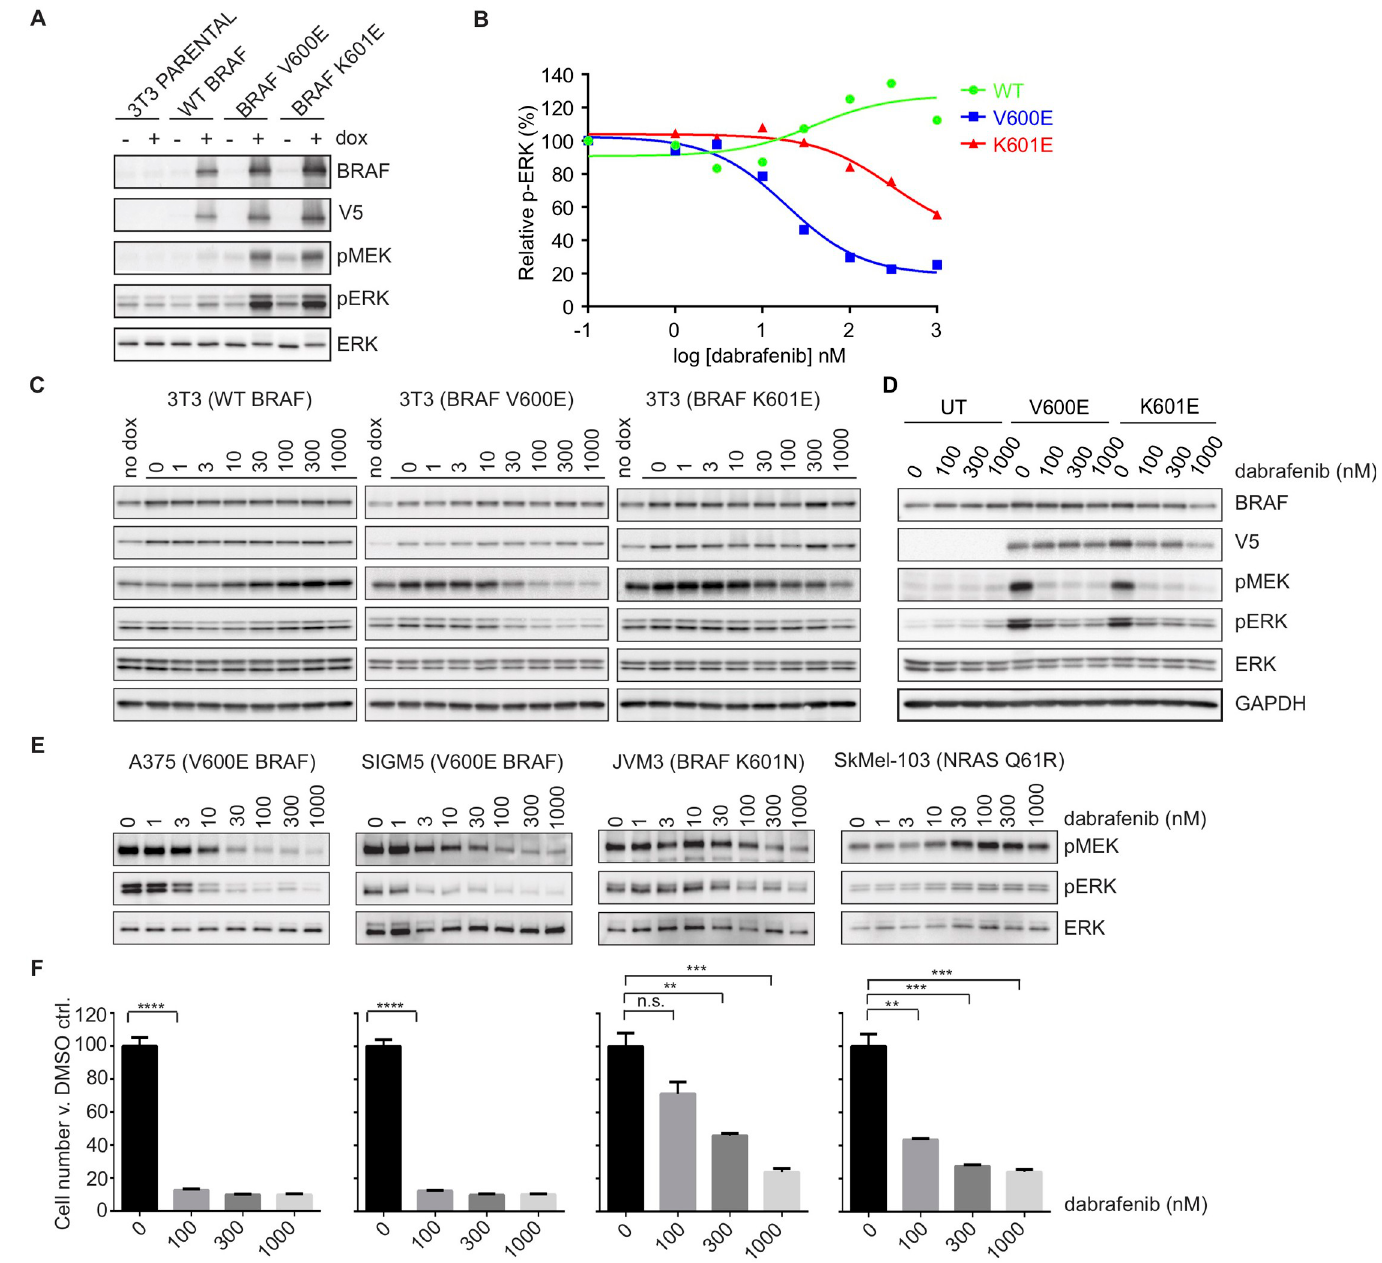
Fig 3. BRAF K601E induces similar levels of phospho-ERK, but has reduced sensitivity to dabrafenib compared to BRAF V600E. A-C. NIH-3T3 cells were stably transfected with doxycycline-inducible BRAF mutants (WT, V600E and K601E). A. Cells were plated in the presence (+) or absence (-) of doxycycline. B-C. Cells were plated in the presence of doxycycline (unless otherwise indicated), followed by treatment with dabrafenib (dose range as shown) for 1 hour (quantitation (B)) is shown for phospho-ERK immunoblots (C). D. NT-3 cells were transiently transfected with BRAF mutants (V600E and K601E) and treated with various doses of dabrafenib (as indicated) for 1 hour. E. Cell lines as shown were treated with dabrafenib, over a dose range, for 1 hour. UT = untransfected. In A–E, expression and/or phosphorylation of the indicated proteins were assessed by immunoblot. F. Cell lines, as in E, were plated in 6-well dishes and treated with the indicated doses of dabrafenib for 72 hrs, in triplicate for each dose shown. Average number of viable cells at 72 hrs is expressed relative to DMSO control for each cell line. Data represent mean ± SEM; ���� , P < 0.0001; ��� , P < 0.001; �� , P < 0.01; � , P < 0.05; n.s. = no significance; unpaired Student’s t-test.